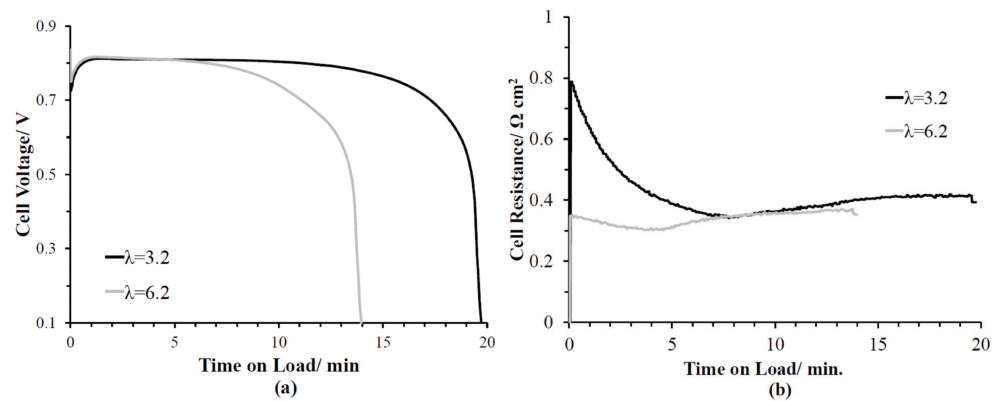
Figure 5. Preconditioned initial water content runs (3.2 and 6.2) isothermal water fill test at 10 mA cm − 2 , / 21% O / 0.1 lpm, respectively). ( a ) Cell voltage and ( b ) cell resistance versus time − 20 ◦ C and H 2 2 (0.05 on